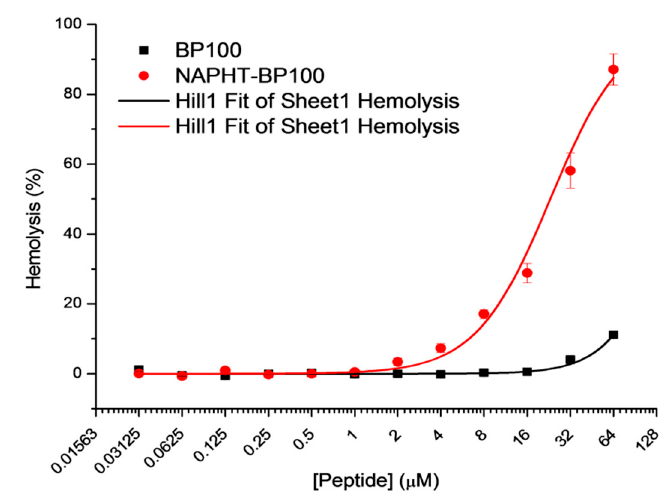
Figure 9. Hemolytic activity of BP100 (black) and NAPHT ‐ BP100 (red) as function of peptide concentration. Red blood cells 1.5% ( v / v ) in PBS, pH 7.0. Temperature was 37 °C.